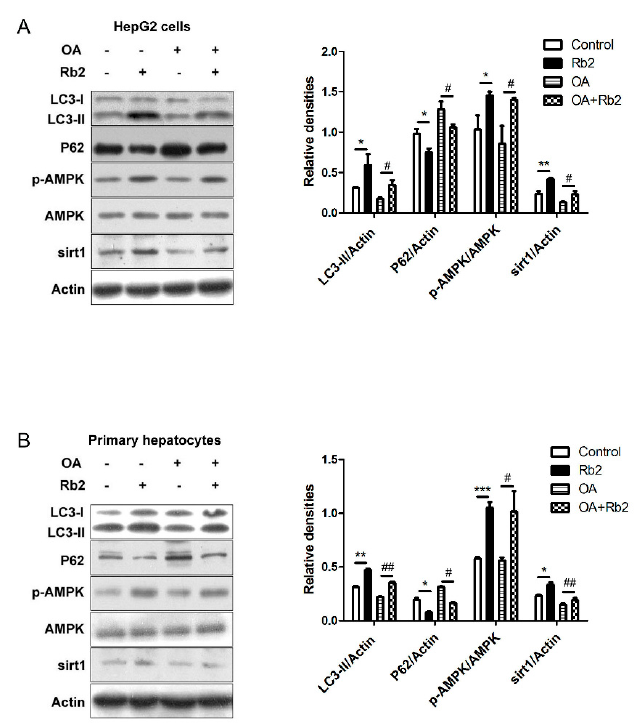
Figure 7. The effect of Rb2 on OA-induced hepatic autophagy dysfunction through the upregulation of sirt1 expression and AMPK phosphorylation. HepG2 cells ( A ) and primary mouse hepatocytes ( B ) were pretreated with 50 µmol/L Rb2 for 4 h before OA (33.3 mmol/L glucose in combination with 1 mmol/L OA for HepG2 and 2 mmol/L OA for primary hepatocytes) exposure for 12 h, and levels of LC3-II, P62, sirt1, p-AMPK, and AMPK were detected by Western blotting analysis. Data are expressed as mean ± SE from three independent experiments. * p < 0.05, ** p < 0.01, and *** p < 0.001 compared with vehicle-treated group (Control). # p < 0.05 and ## p < 0.01 compared with OA-treated group (Control).